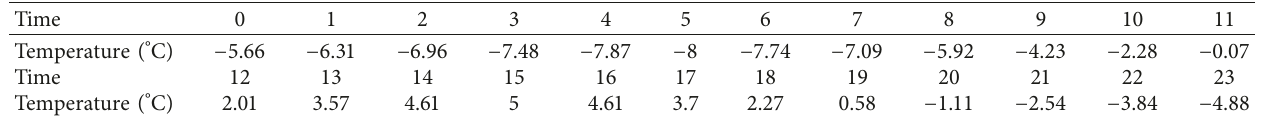
Table 2: Predicted uphole temperatures.